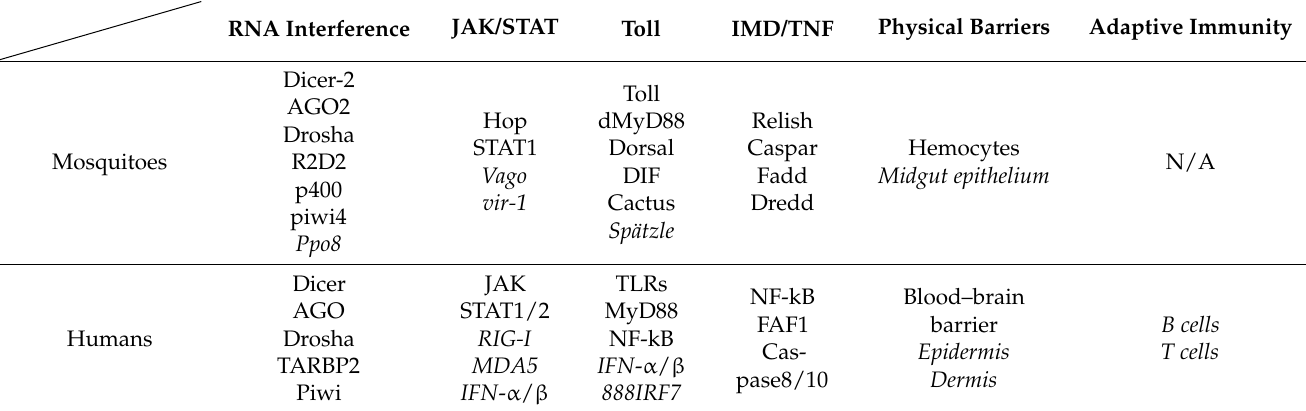
Table 1. Host factors involved in responses to mosquito-borne viruses.